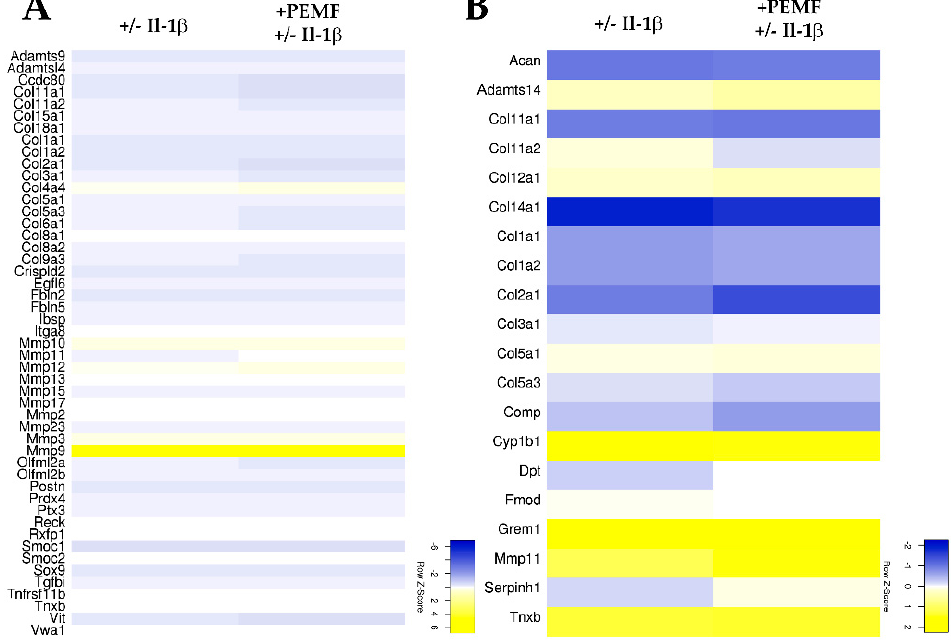
Figure 4. Heatmaps summarizing the differential expression of genes associated ( A ) with GO term “extracellular matrix organization” and ( B ) genes assigned to the GO term “collagen fibril organization” ( ≥ 2.0 fold change; p value < 0.05).